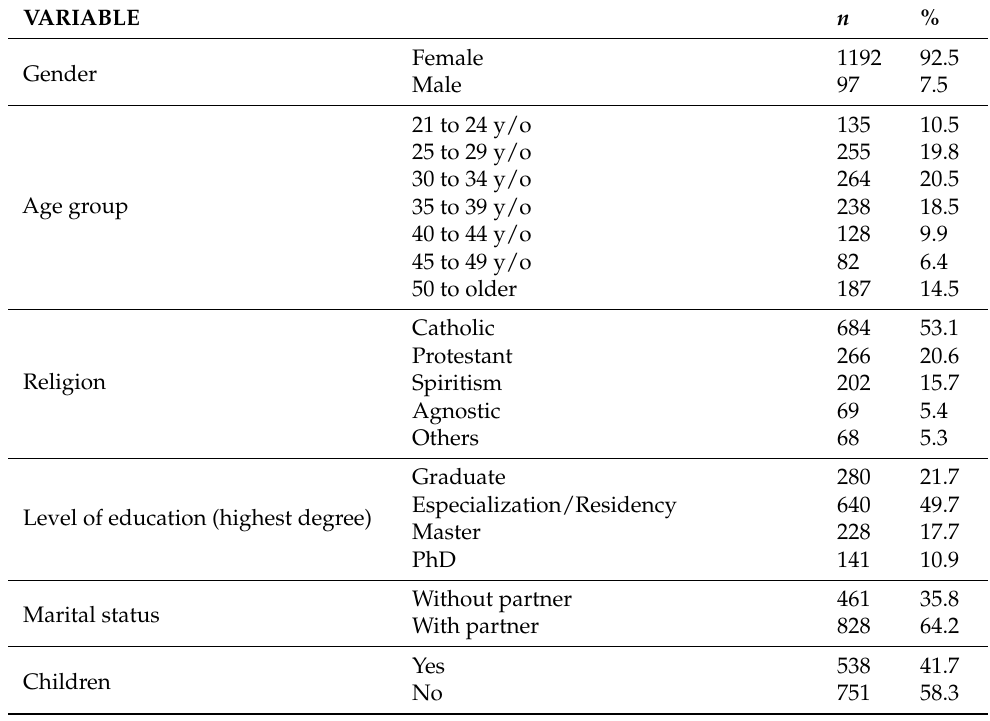
Table 1. Characterization of Brazilian dietitians and SARS-COV-2 questions ( n = 1290).